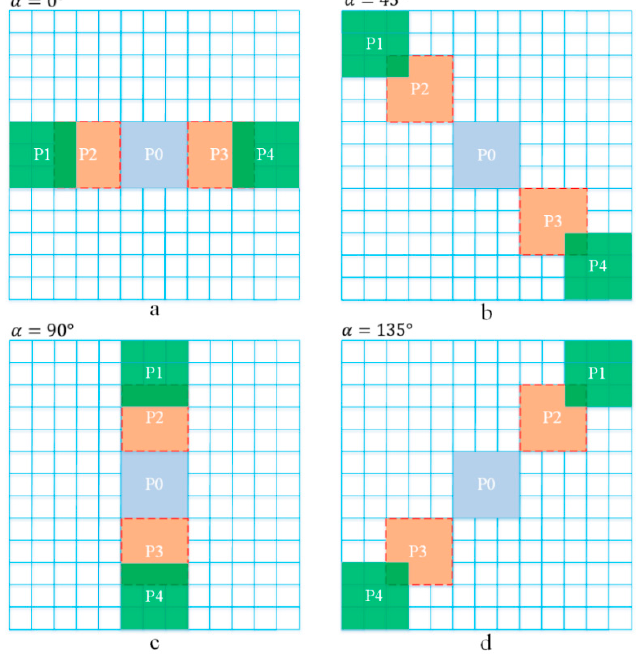
Figure 6. ( a – d ) Local second-order derivative in four directions.